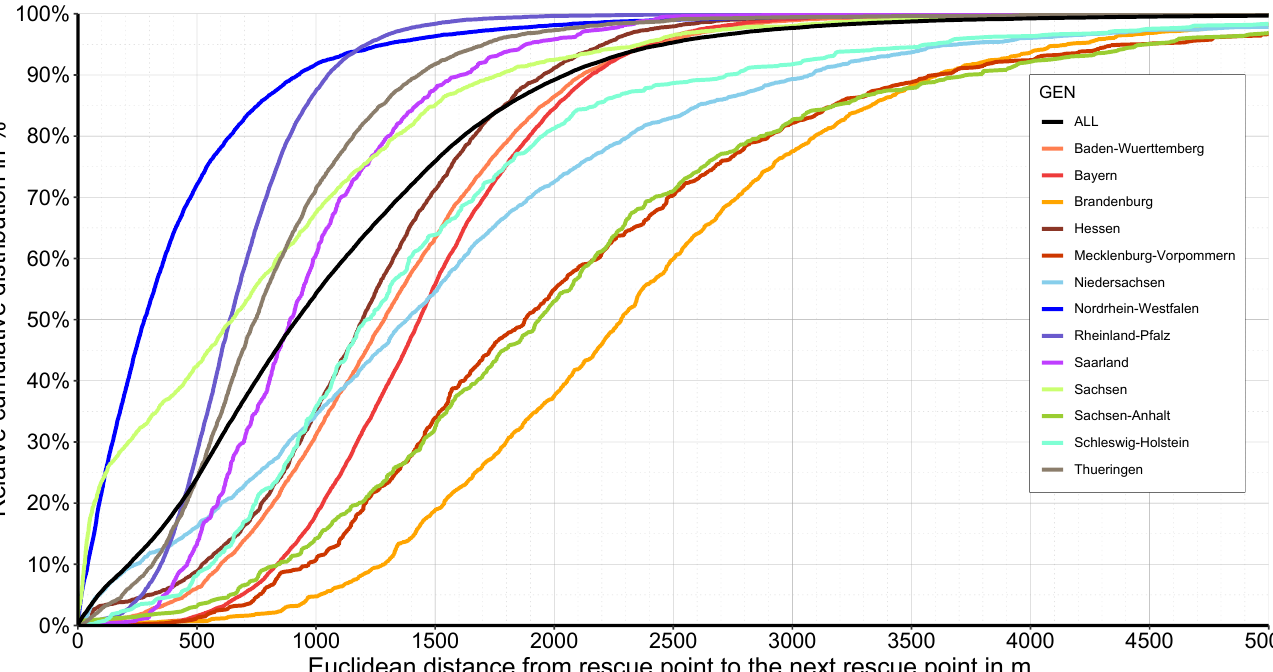
Figure 11. Relative cumulative distribution of the Euclidean distance from a rescue point to the nearest forest for the different federal states and the federal level.